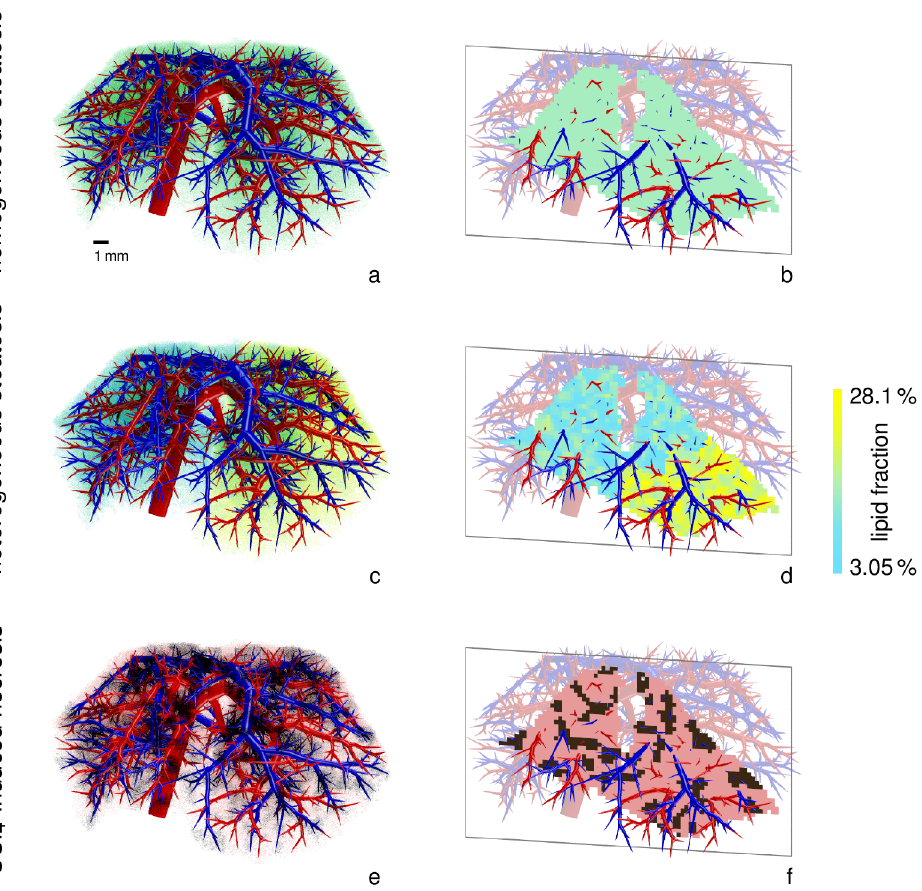
Figure 4. Visualization of pathophysiological states (steatosis, CCl 4 -induced necrosis) in the spatially resolved liver model. The images show the distribution of lipid in our steatotic model with homogeneous lipid accumulation throughout the whole liver ( a, b ) and different heterogeneous distributions ( c, d ) in the left lateral lobe and the remaining lobes. The average lipid accumulation over the whole liver is the same in both steatosis cases. The lipid accumulation is assumed to change the distribution and metabolization behavior according to Equation 9. The liver volume affected by CCl 4 -induced necrosis is shown in dark at the bottom ( e, f ). In each case, a volume rendering ( a, c, e ) and one coronal slice through the model liver ( b, d, f ) is shown along with the vascular